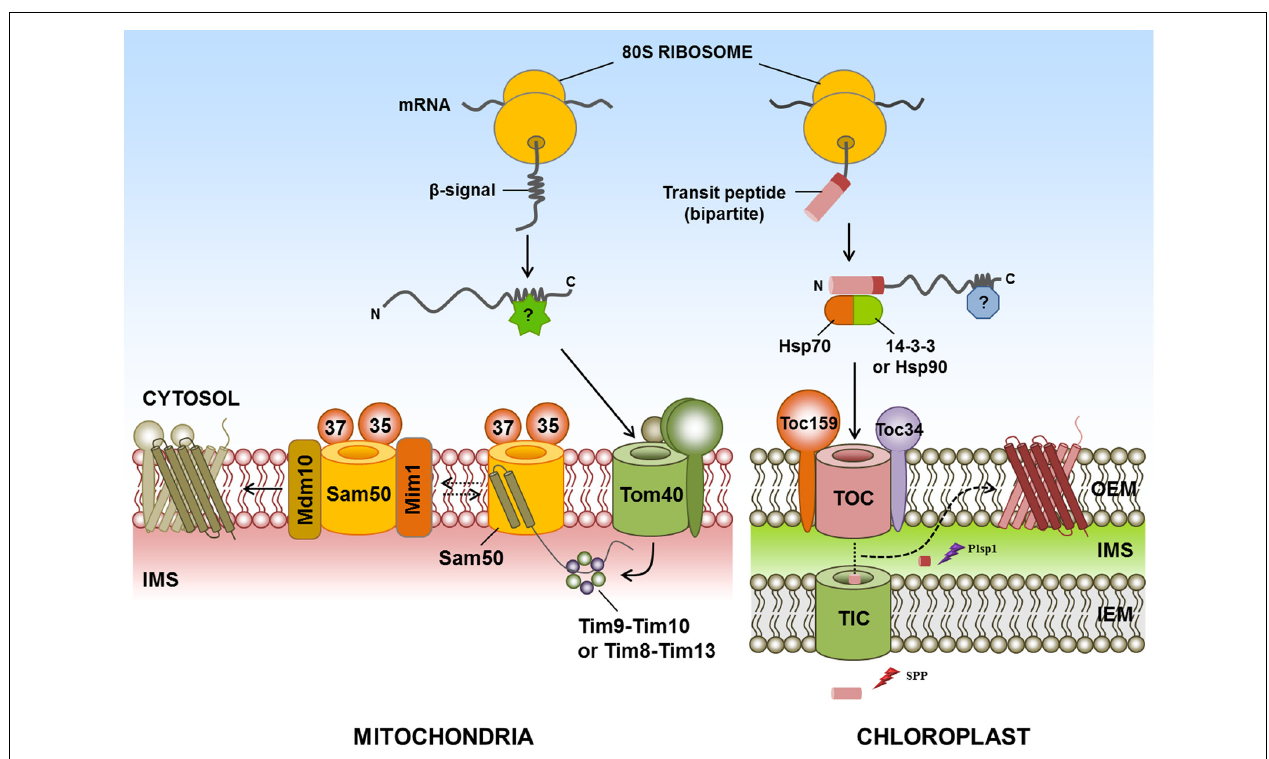
FIGURE 1 |Targeting of β -barrel proteins to the chloroplast and mitochondrial outer membranes. Specific cytosolic factors for targeting of β -barrel proteins of the chloroplast and mitochondria have not yet been identified in plants, mammals, or yeast. The chloroplast outer membrane-targeted β -barrel proteins Toc75, OEP24, and OEP37 have (or are predicted to have) typical transit peptides. For chloroplast targeting, Toc75 requires an N-terminal transit peptide comprising two parts. The first part of the targeting signal is cleaved in the stroma by SPP, whereas the second part is removed by Plsp1. However, the exact mechanism of insertion of β -barrel proteins into the chloroplast outer membrane is still unknown. In the mitochondrial outer membrane-targeted β -barrel proteins, cytosolic β -barrel precursors are recognized by the TOM complex and